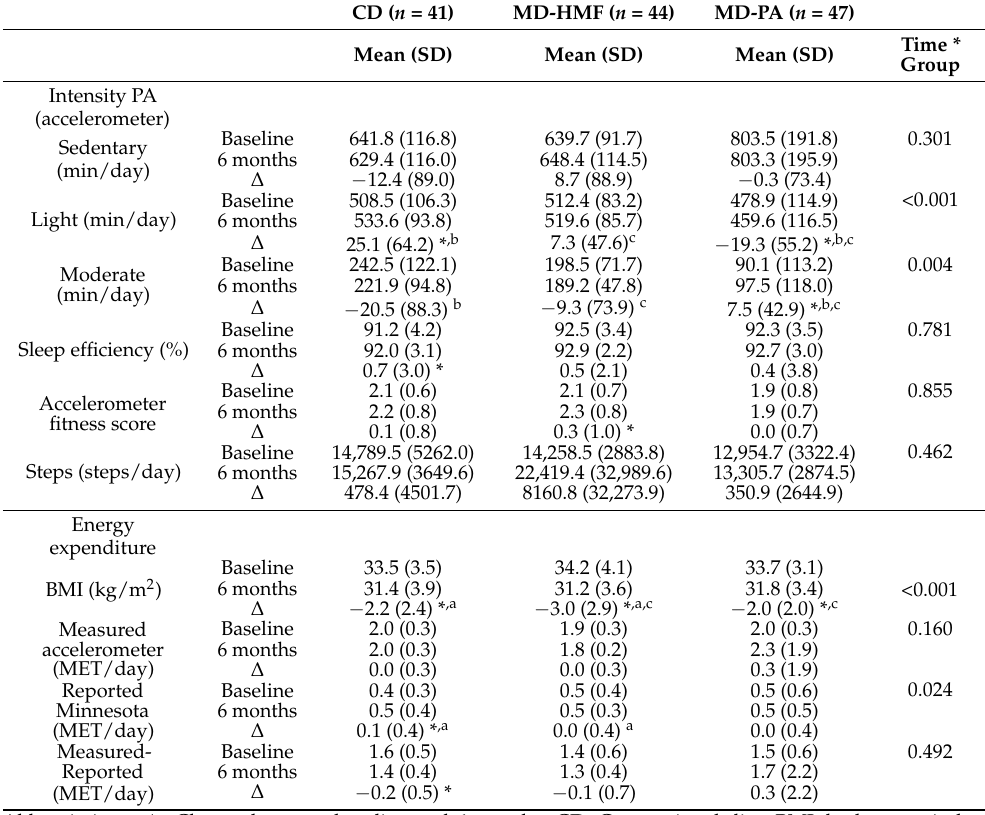
Table 3. Changes in physical activity parameters from accelerometers within and between interven- tion groups at 6 months versus